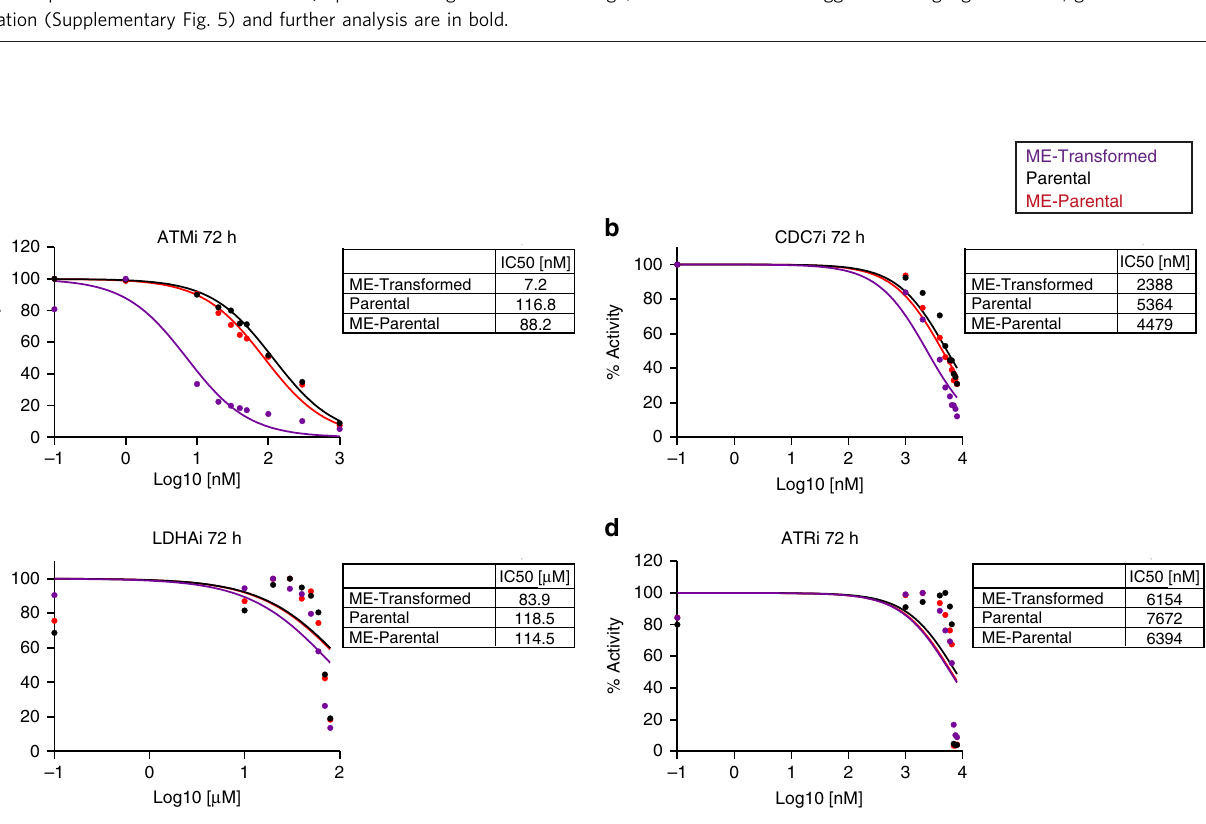
Fig. 5 Genome-wide drop-out screens identify new therapeutic targets. a Summary of the experimental approach. Parental and ME-Transformed cells were obtained as described in Fig. 1a from Cas9-expressing Hoxb8-FL cells. Then, Parental cells (cultured in self-renewal conditions) and ME-Transformed